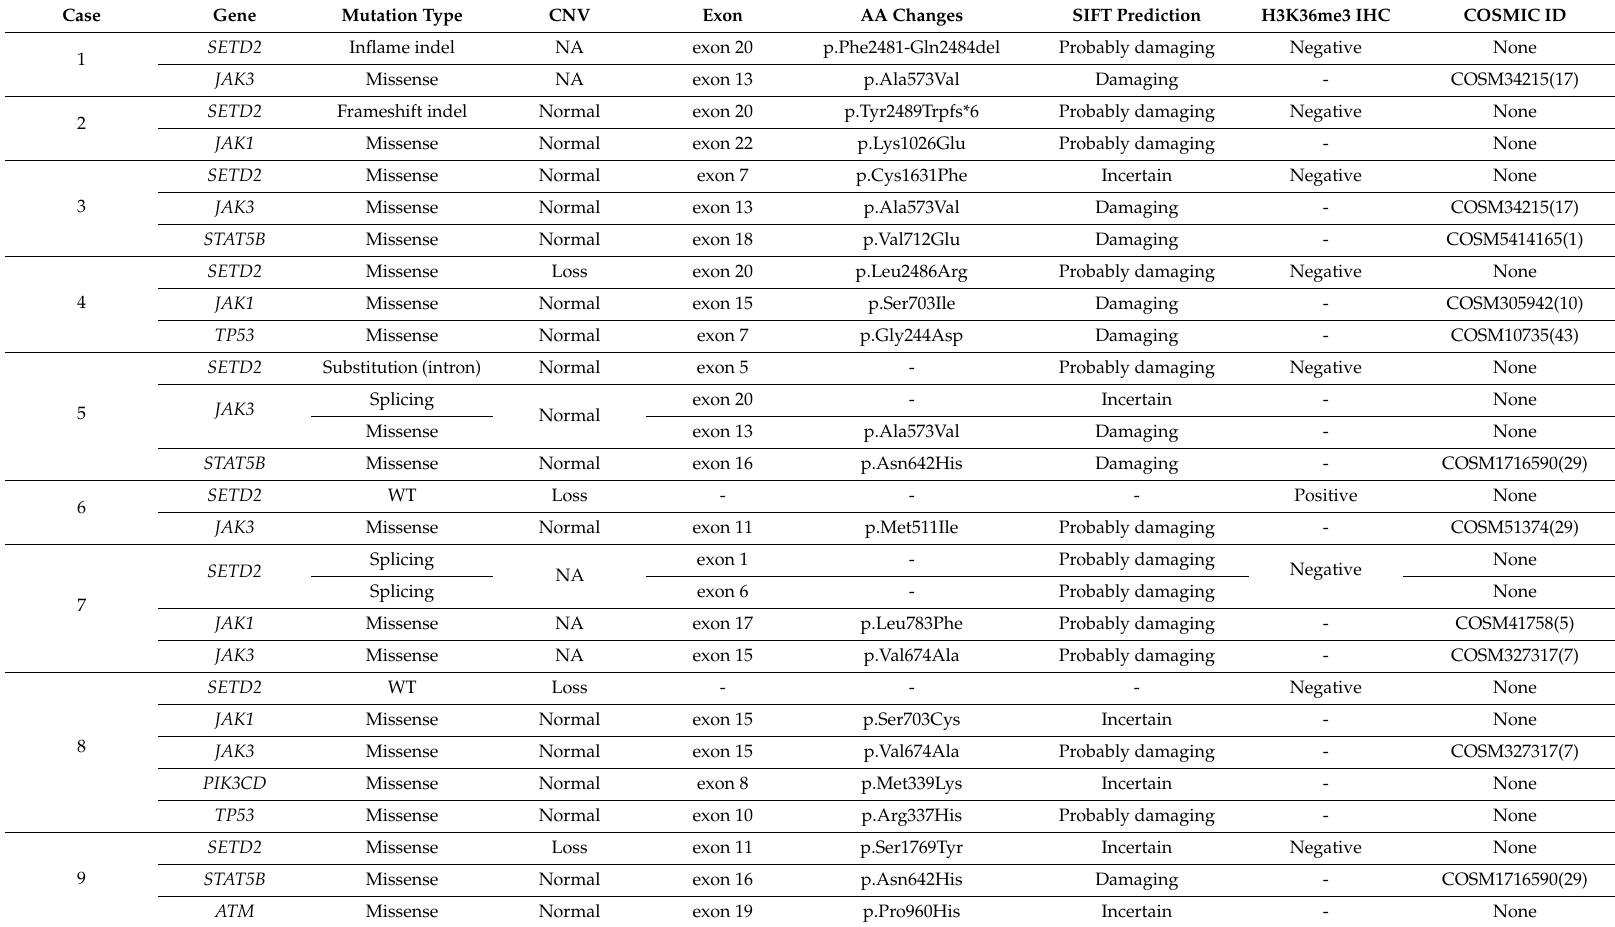
Table 2. Summary of DNA sequencing and IHC of